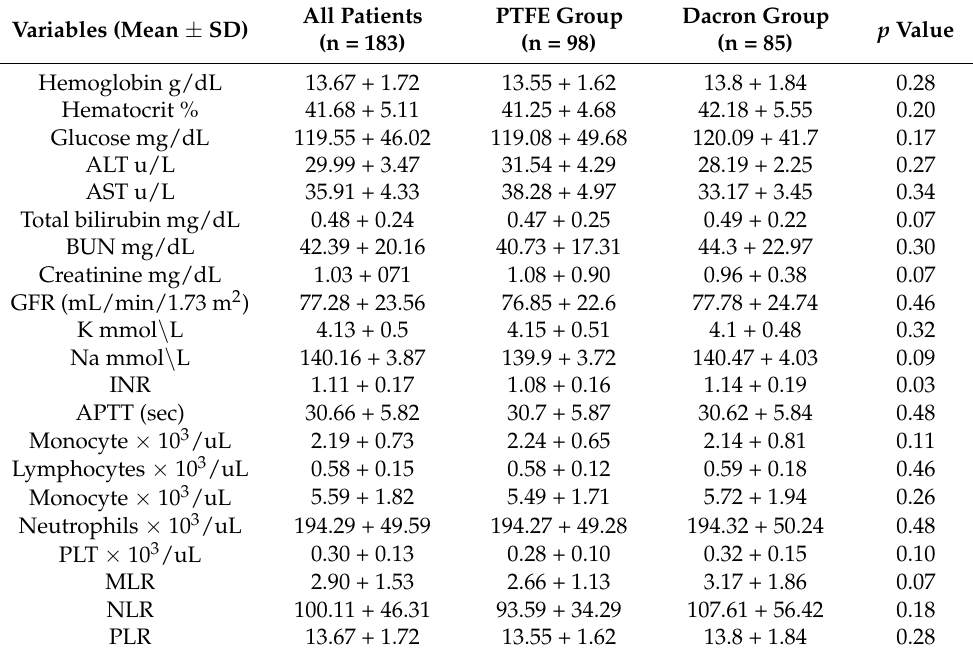
Table 2. Laboratory data for all patients, PTFE group and Dacron group. Variables (Mean ±